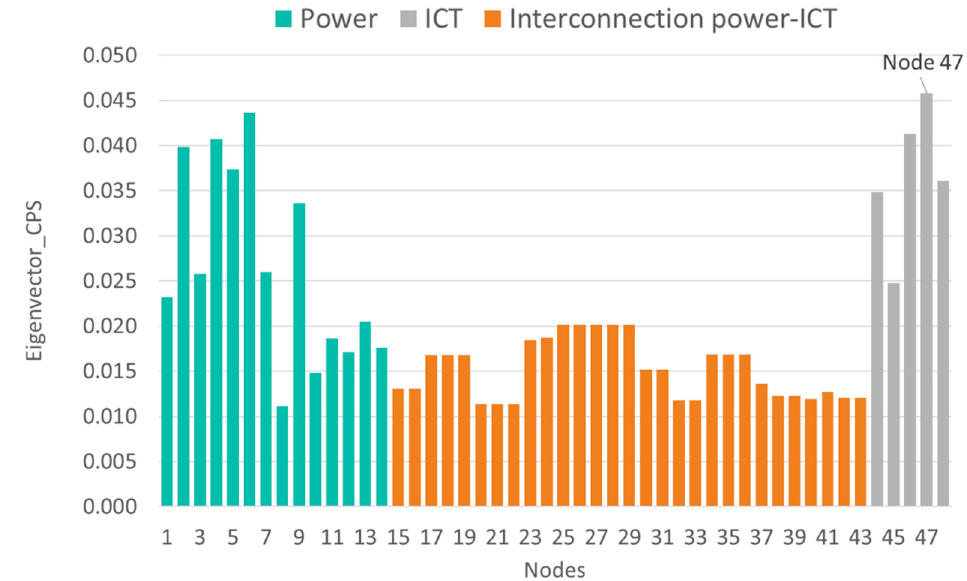
Figure 9. Eigenvector vulnerability values of the cyber-physical IEEE 14-bus test case.